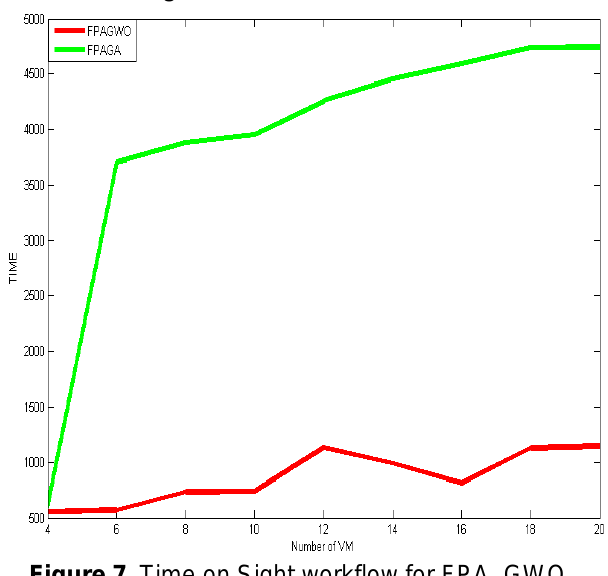
Figure 5. Time of Genome workflow for FPA_GWO